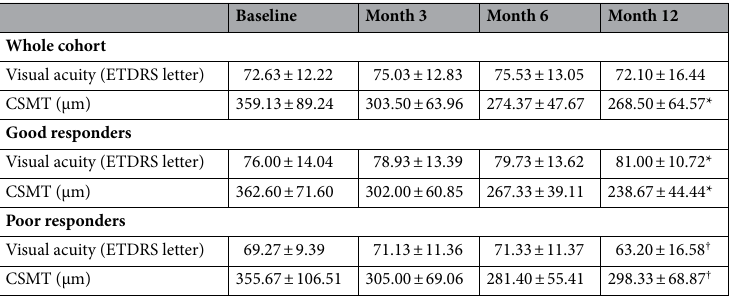
Fig. 1A–D. Ellipsoid zone and ELM integrity and hyperreflective foci in the OS and ON layer (also known as intra and subretinal precipitates) were found to be significant factors in differentiating mineralocorticoid receptor antago- nist treatment response. In patients who showed complete resolution of subretinal fluid at the 1-year follow-up, a